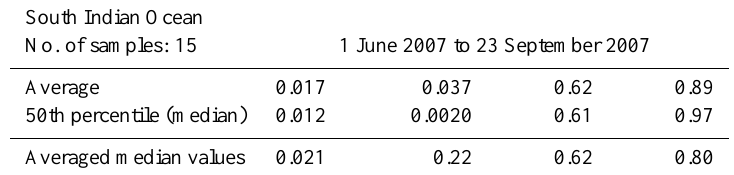
Table 4. Samples collected at MCOH during the two data selections. The average of median values is calculated using the median values from the optical and chemical corrected BC concentrations. BC average values are in µgm − 3 , all other values are dimensionless ratios. BC mass concentrations were derived using a mass absorption cross-section of 10 ± 1m 2 g − 1 . BC/ BC Optical Chemical Total Average of correction correction mass median mass effect effect Arabian Sea No. of samples: 40 18 Mars 2007 to 3 May 2007